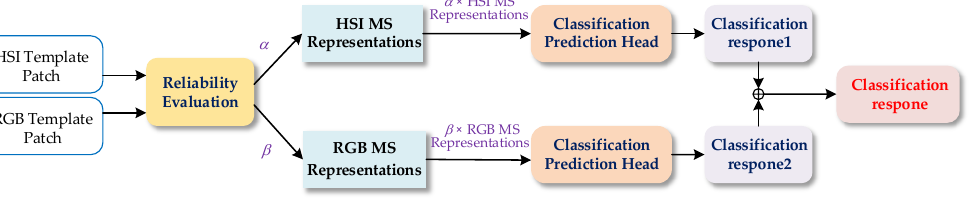
Figure 8. Structure of the classification response aggregation module. α and β represent the predicted contribution of HSI and RGB, respectively. The symbol ⊕ represents the merge